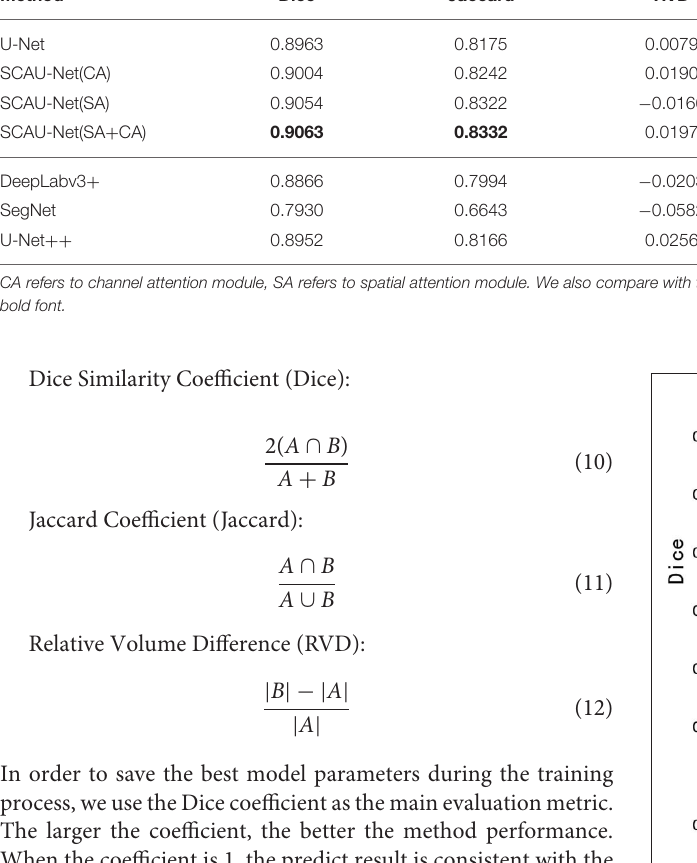
TABLE 1 | Our method’s segmentation results compare with U-Net on dataset GlaS and CRAG. GlaS CRAG Method Dice Jaccard